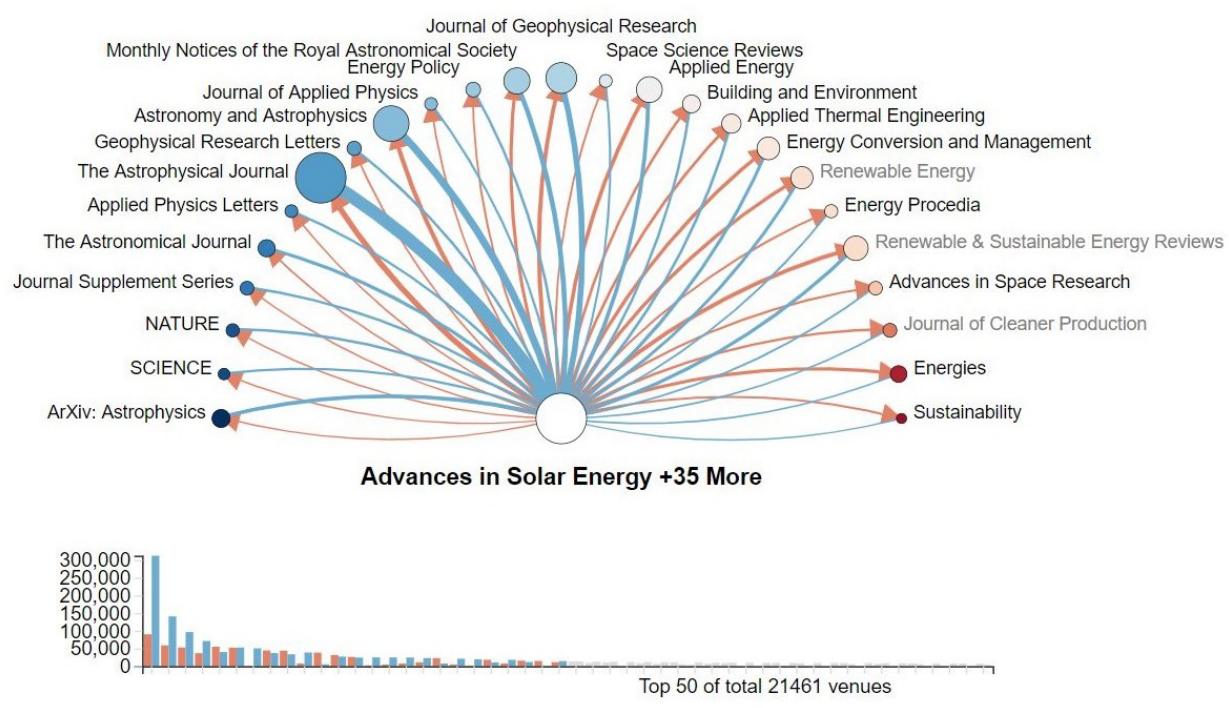
Figure 6. Influence flower visualizes publications and citations connections between authors.